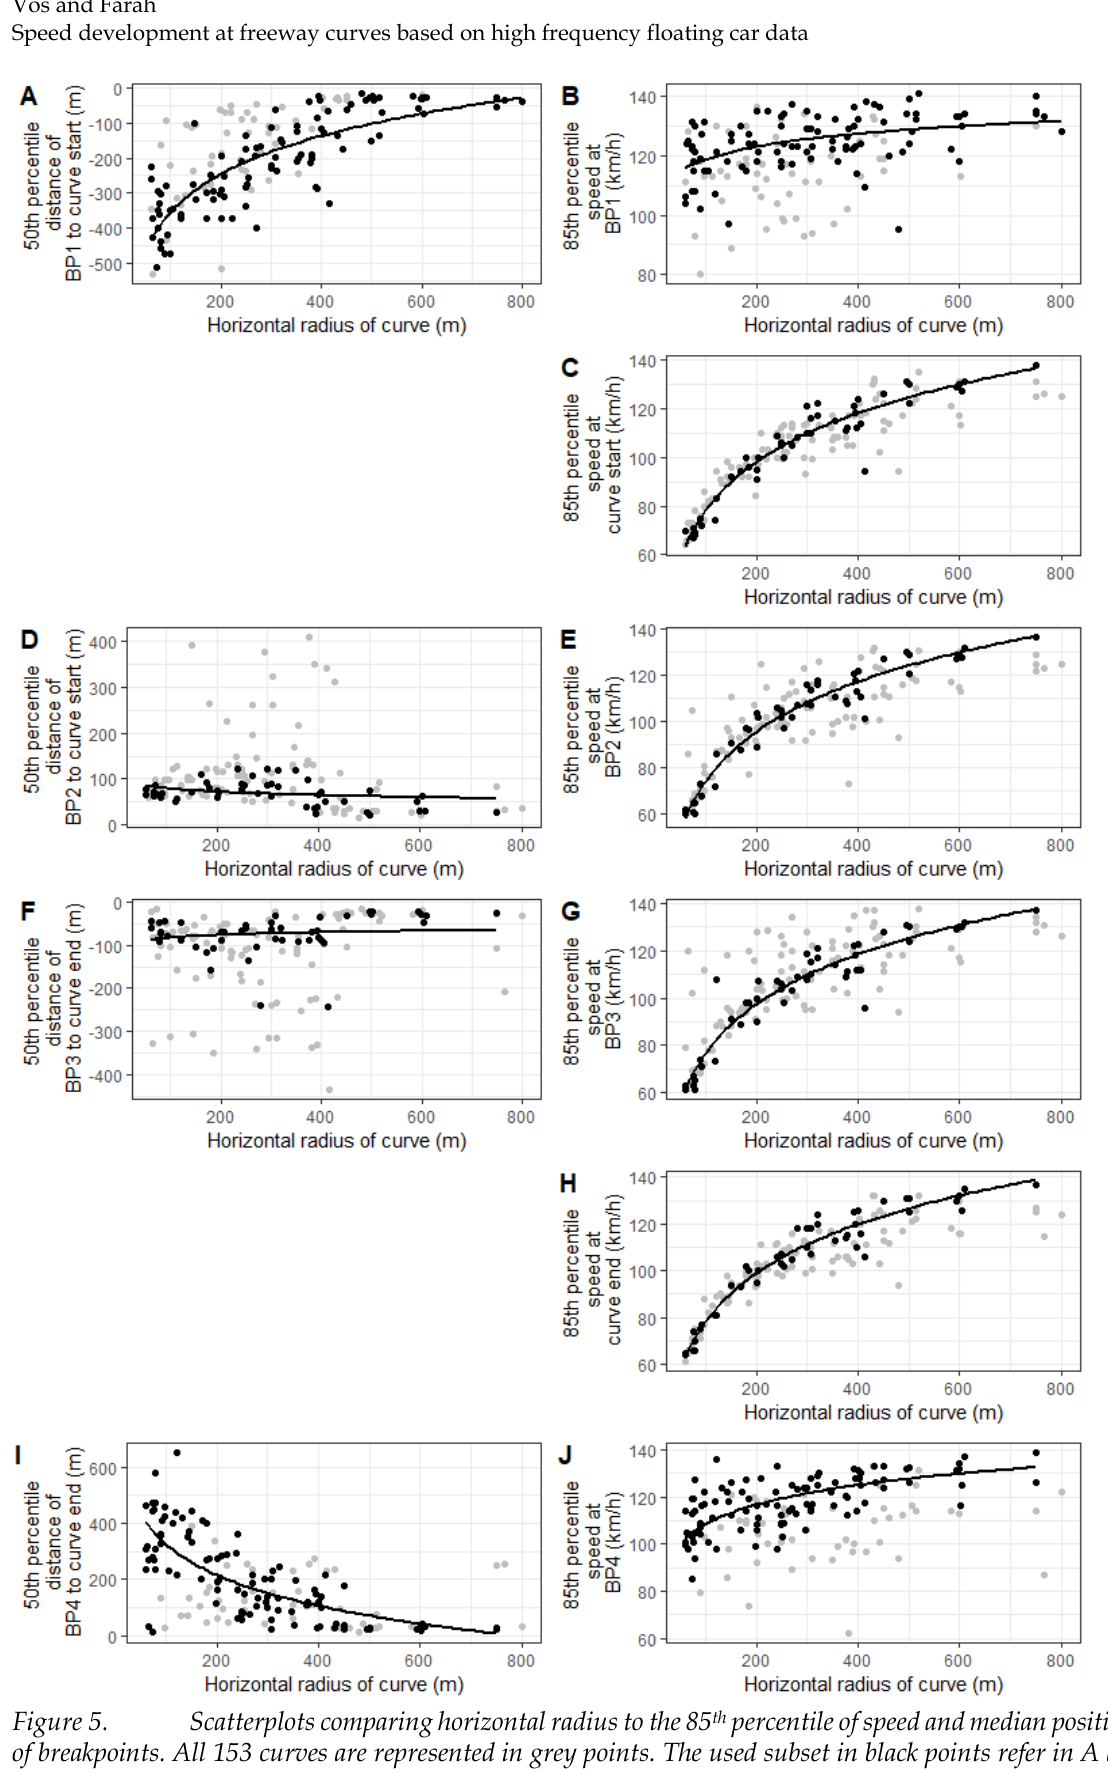
Figure 5. Scatterplots comparing horizontal radius to the 85 th percentile of speed and median positions of breakpoints. All 153 curves are represented in grey points. The used subset in black points refer in A and B to first curves, C through H to single curves, and for I and J to last